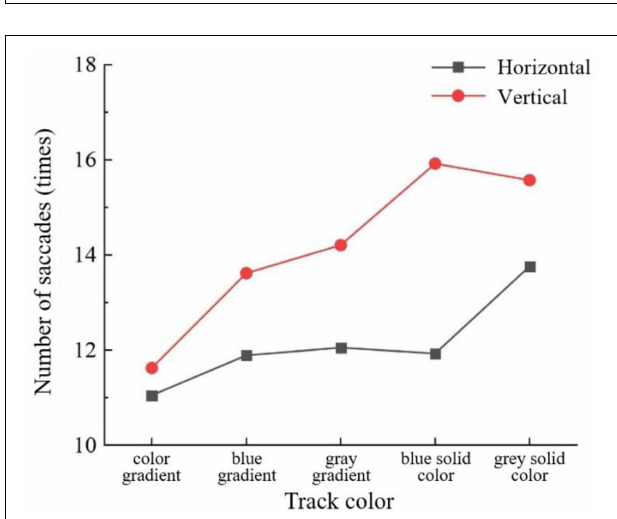
FIGURE 7 | Number of saccades by button size and sliding orientation for the middle-aged and elderly